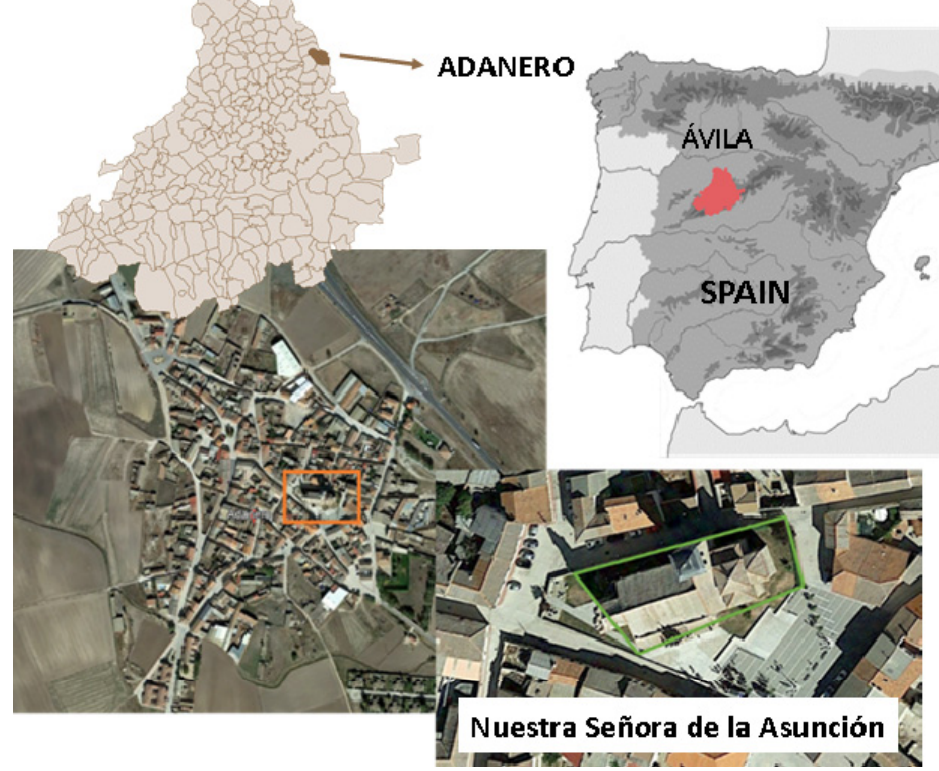
Figure 1. Location of the church of Nuestra Señora de la Asunción (Ávila, Spain). The current apse of the church has a Baroque style, being covered by a lunette vault. These vaults are also in the transept, having a span of 3.50 m. The cross of the church is presented by a hemispherical dome with Baroque decoration and a diameter of 6.00 m.